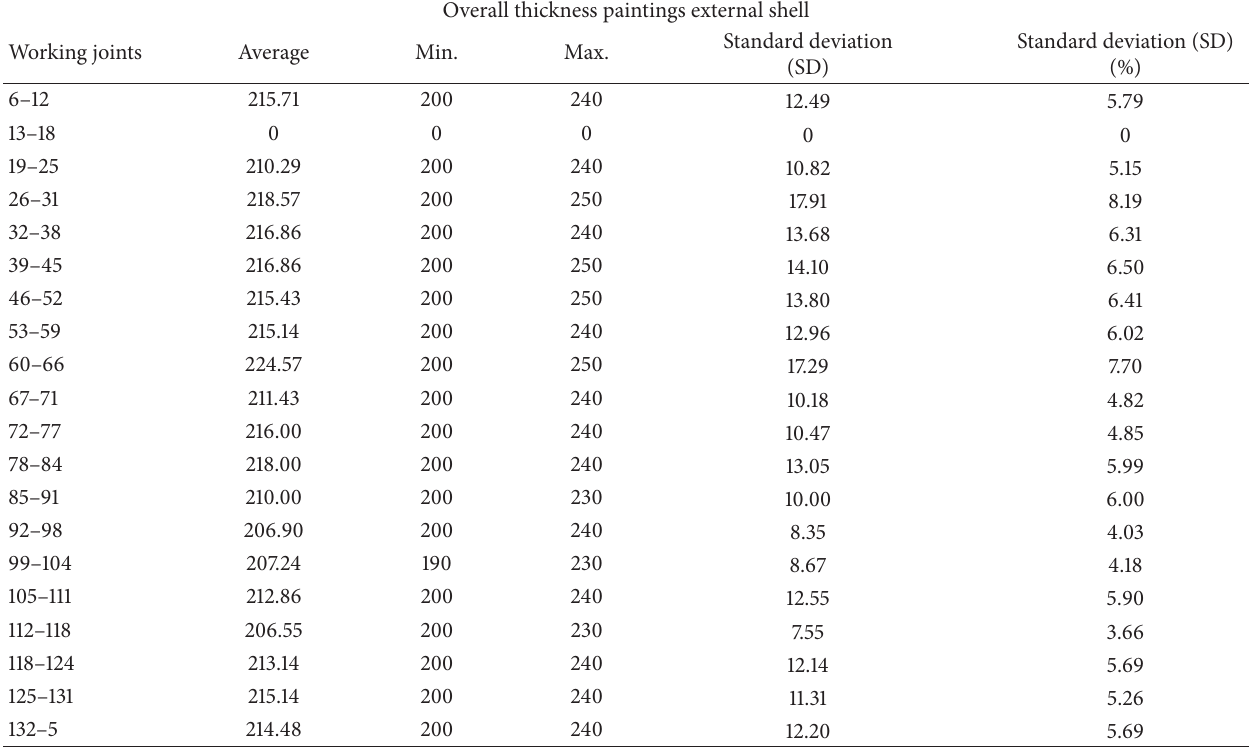
Table 5: Total thickness of organic coatings ( 𝜇 m) on the concrete surface external shell under the ring.